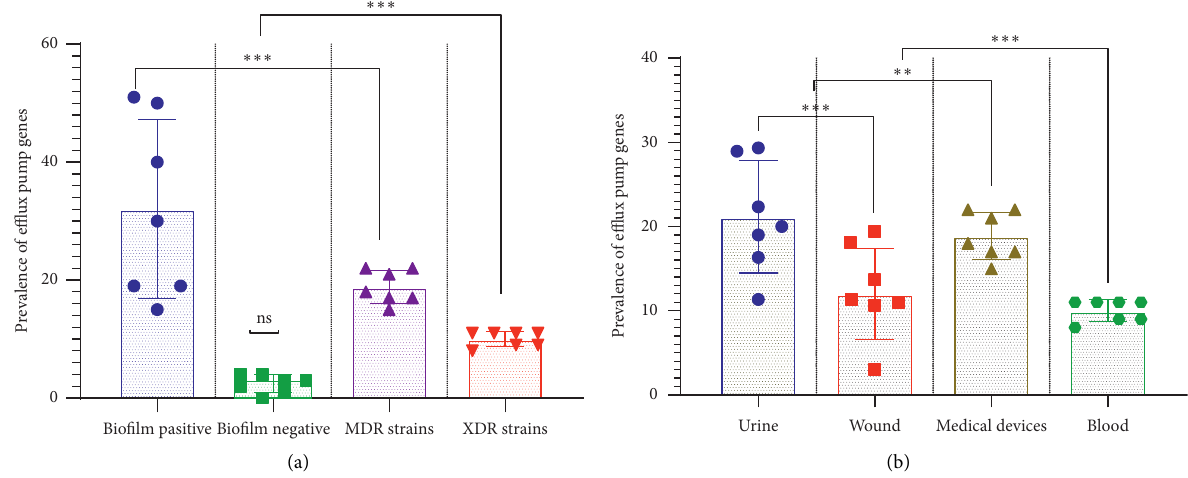
Figure 3: Association between efflux pump genes, antibiotic resistance, biofilm formation, and clinical samples in P. aeruginosa isolates. (a) Association between efflux pump genes, antibiotic resistance, and biofilm formation. (b) Association between efflux pump genes and clinical samples. Each dataset was analyzed using Student’s t -test and the two-way ANOVA and was presented as Mean+SEM. ∗ p value < 0.05; ∗∗ p value < 0.01; ∗∗∗ p value < 0.001; and ∗∗∗∗∗ p value < 0.0001. ns: nonsense. Table 3: Correlation between efflux pumps, biofilm formation, separated clinical isolates, and antibiotic resistance in P. aeruginosa .